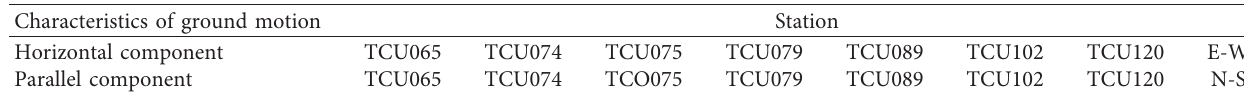
Figure 15: The average peak interstory shear force of the structure under seismic excitations with velocity pulse: (a) the SSI system without viscous dampers; (b) the SSI system with viscous dampers; (c) the ground motion of TCU051E. Table 5: The selected forward-directivity ground